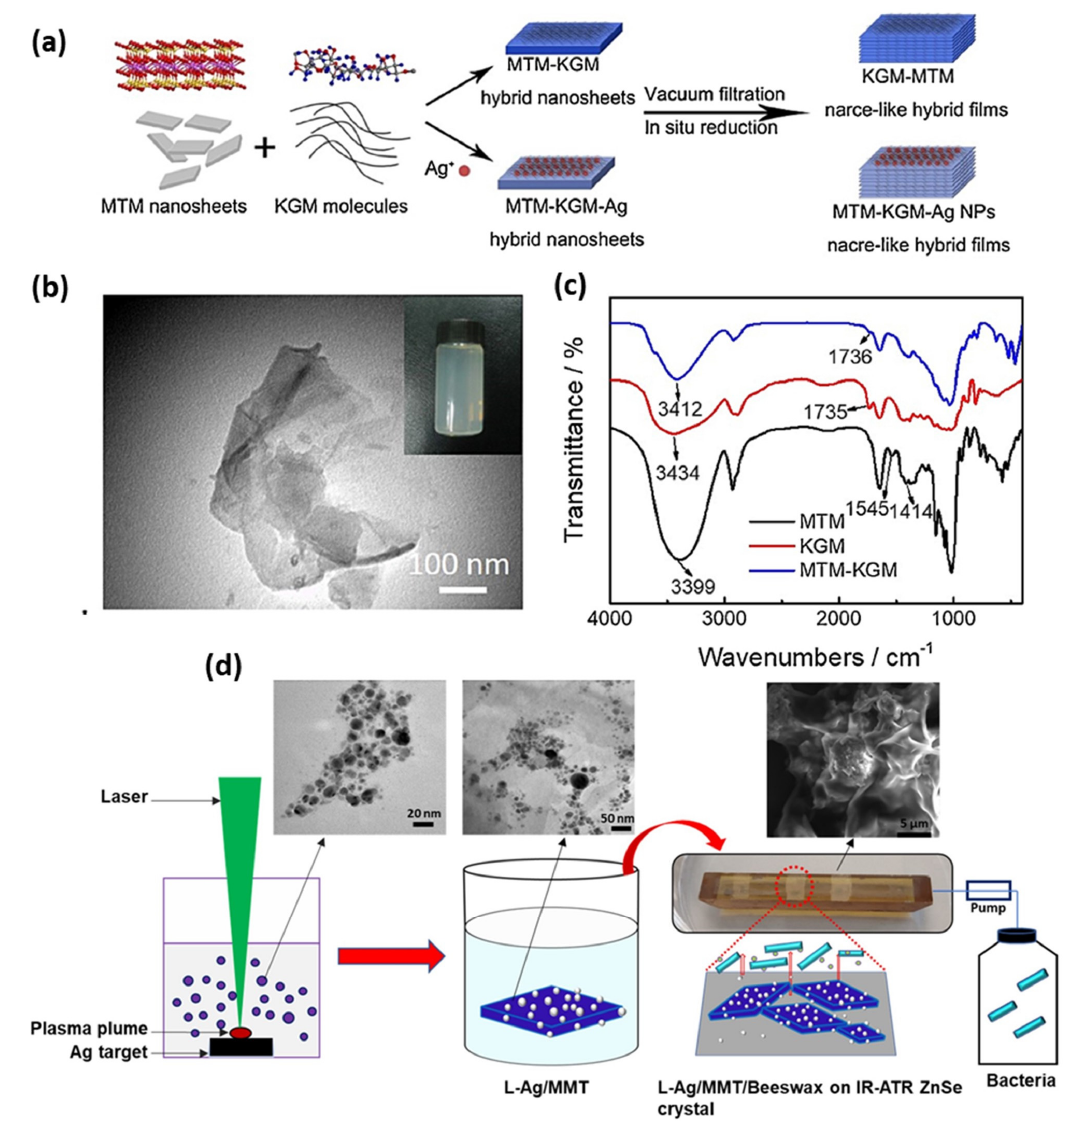
Figure 1. ( a ) Schematic preparation process of the composite films. ( b ) TEM images of